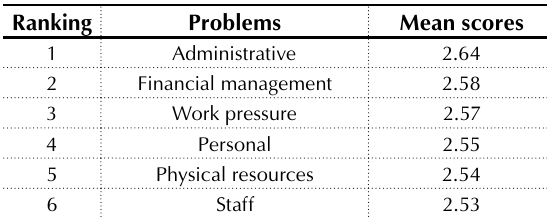
Table 2. Mean scores of problems experienced by deputy principals in rank order